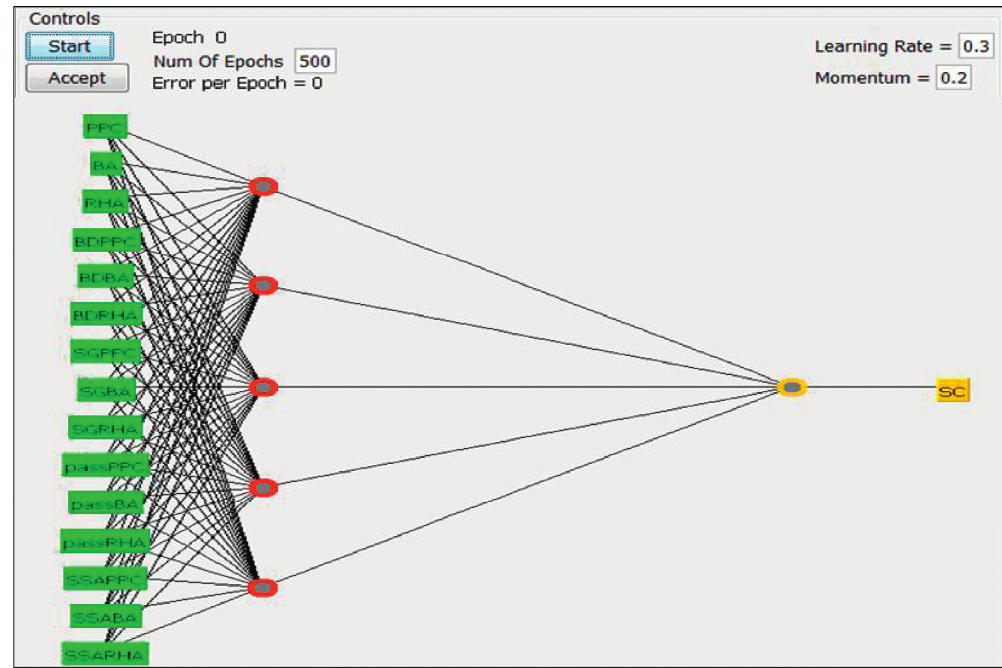
Figure 1: ANN model (PPC: Portland Pozzolana cement; BA: bagasse ash; RHA: rice husk ash; BDPPC, BDBA, and BDRHA: bulk density of PPC, BA, and RHA; SGPPC, SGBA, and SGRHA: specific gravity of PPC, BA, and RHA; passPPC, passBA, and passRHA: percentage passing 45 µ m in the sieve; SSAPPC, SSABA, and SSARHA: specific surface area of PPC, BA, and RHA).